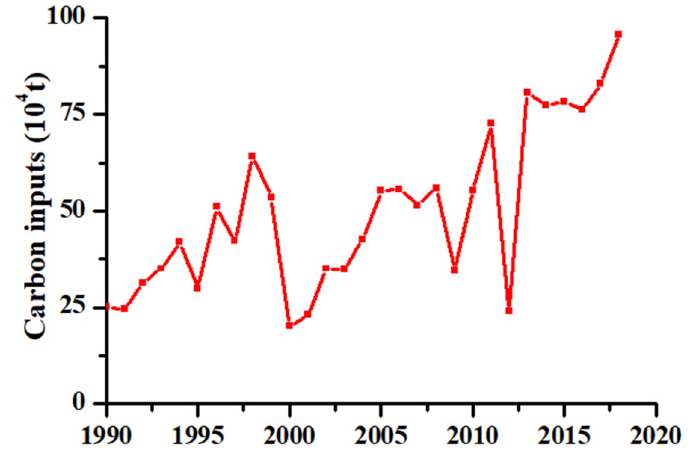
Figure 9. Crop root carbon inputs since 1989 (carbon inputs by roots were estimated using the crop yield data referenced by [21]).